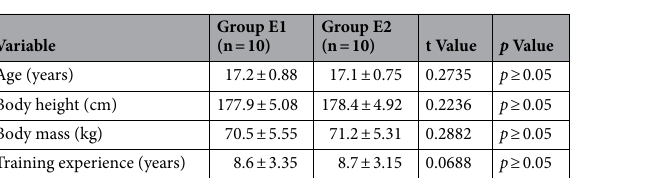
Table 2. Anthropometric characteristics and training experience of youth soccer players (mean ± SD). E1—6 × 30 s 1 × 1 SSGs, E2—6 × 45 s 1 × 1 SSGs.